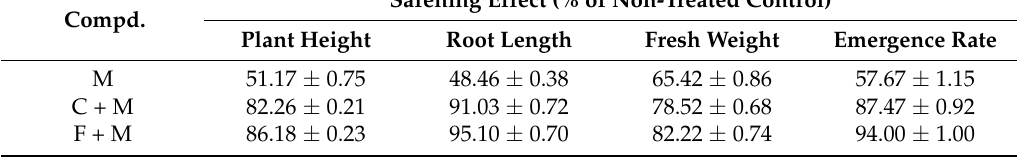
Table 4. Herbicide safening effect of 7-day-old rice seedlings treated with metolachlor. The combined